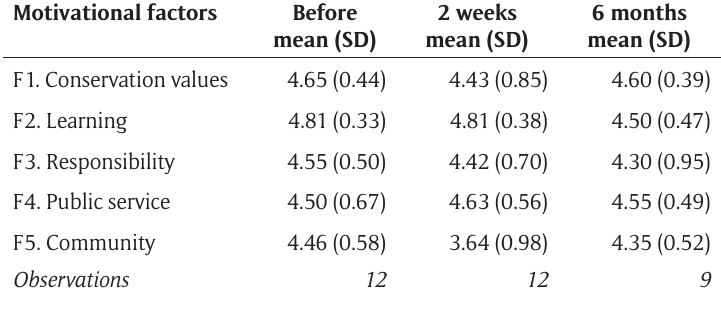
Table 3: Volunteer motivations to participate in rainfall monitoring before, two weeks after, and six months after training by factor (5-point Likert Scale).